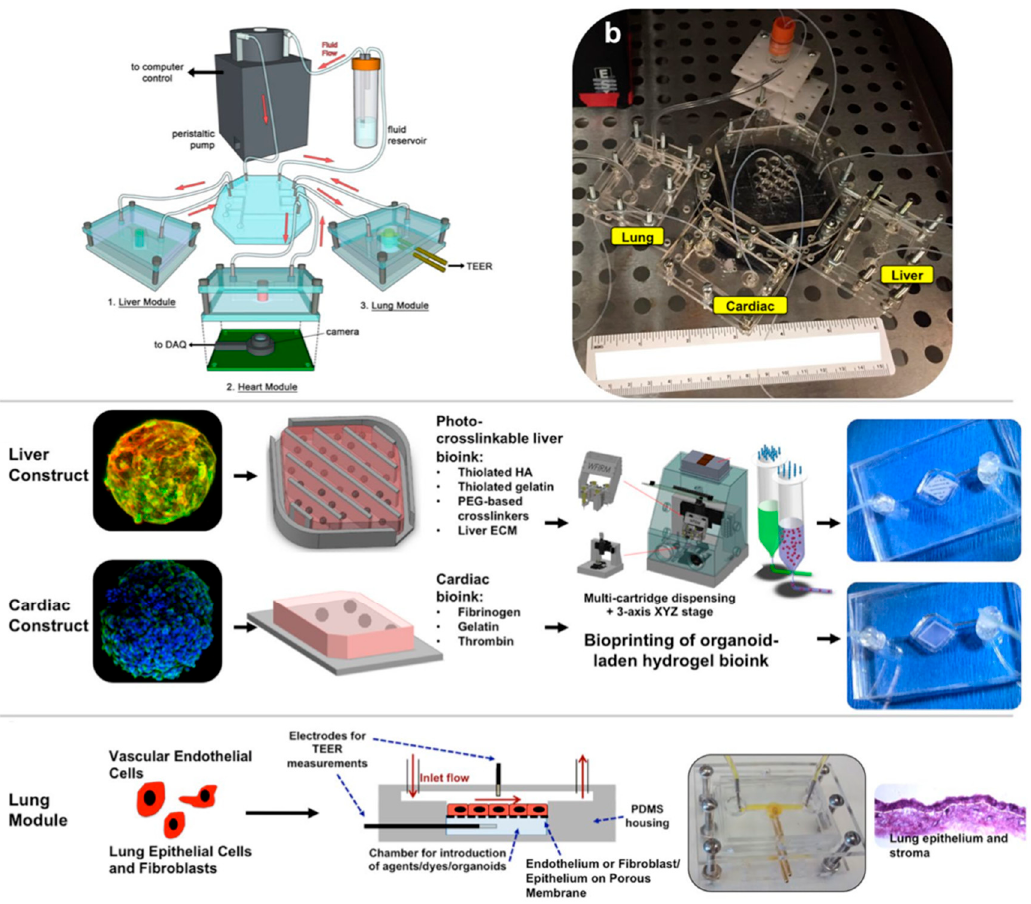
Figure 12. “plug-and-play” 3-tissue-representative organ-on-a-chip system. Liver and cardiac modules are created by bioprinting spherical organoids within customized bioinks, resulting in 3D hydrogel constructs that are placed into the microreactor devices. Lung modules are formed by creating layers of cells over porous membranes within microfluidic devices. Introduction of TEER sensors allows monitoring of tissue barrier function integrity over time. (Reproduced from